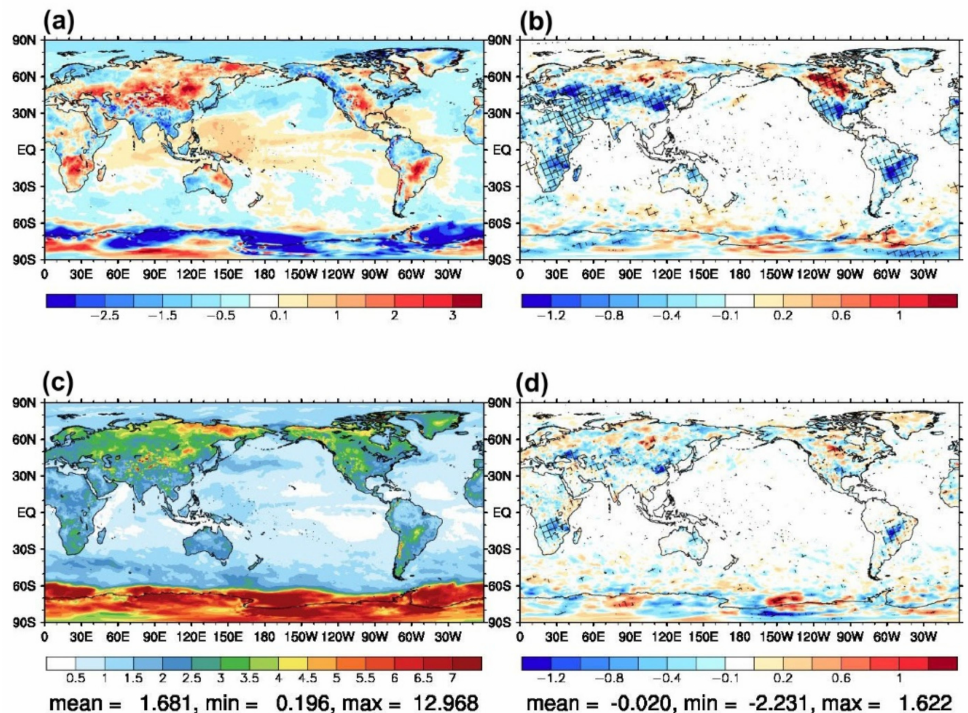
Figure 9. ( a ) Biases and ( c ) RMSEs of 2-m air temperature in the CTL against the ERA5 reanalysis, and ( b ) differences in the biases and ( d ) RMSEs between the EXP and CTL over the period of 1 July 2019 to 10 August 2019 for a five-day forecast. The hatched regions indicate a difference significant at the 95% confidence